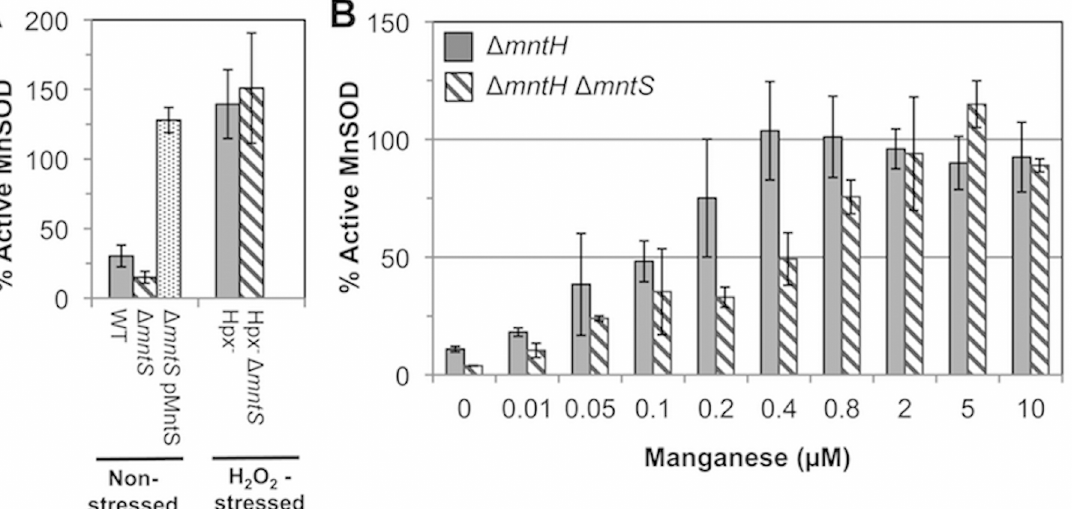
Fig 2. MntS facilitates the activation of manganese-dependent superoxide dismutase. The fraction of MnSOD protein that is catalytically active was measured in cell extracts prepared from cultures grown aerobically in M9 glucose/casamino acids media containing the indicated concentrations of MnCl 2 . All strains contain the sodB -null allele. Data represent the mean of three independent cultures. A. MntS assists manganese insertion into MnSOD in manganese-poor cells. Strains were JEM1233 (WT), JEM1234 ( Δ mntS ), JEM1311 ( Δ mntS with pMntS2, mntS under the control of its native promoter), JEM1208 (Hpx - ), and JEM1212 (Hpx - Δ mntS ). The Δ mntS allele had minimal impact upon the amount of total MnSOD protein, as indicated by the activity after reactivation. B. MntS helps activate MnSOD when manganese concentrations are low. Strains were JEM1235 ( Δ mntH ) and JEM1237 ( Δ mntH Δ mntS